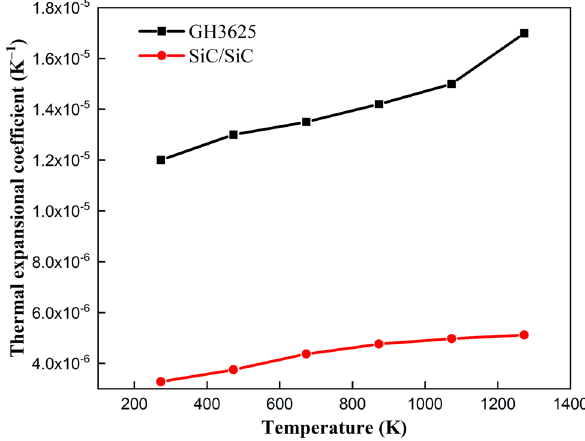
Figure 7: Comparison of thermal expansional coe ffi cient of GH3625 alloy material and SWS - SiC/SiC composite.